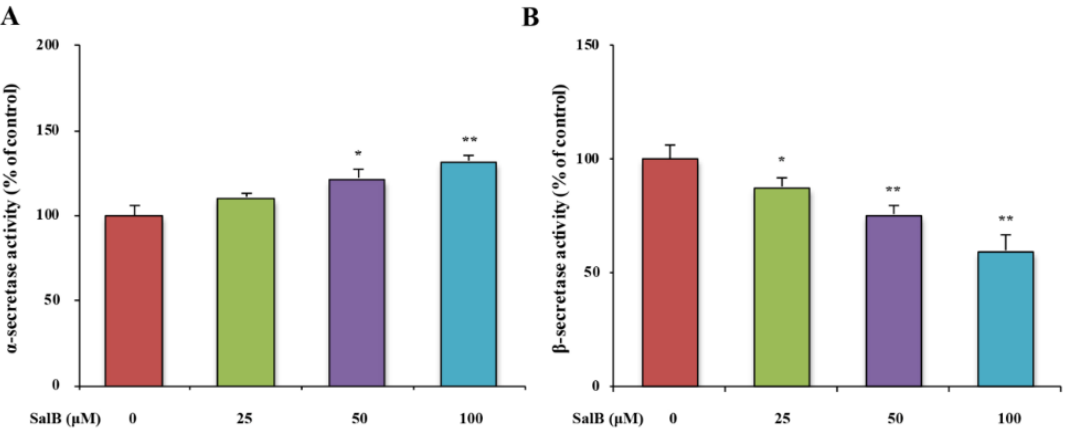
Figure 5. Effect of SalB on α - and β -secretase activities in SH-SY5Y-APPsw cells. α - ( A ) and β -secretase ( B ) activities were measured in SH-SY5Y-APPsw cells. Values are expressed as the mean ± SD in each group ( n = 3). * p < 0.05, ** p < 0.01 vs. control. SalB: Salvianolic acid B.